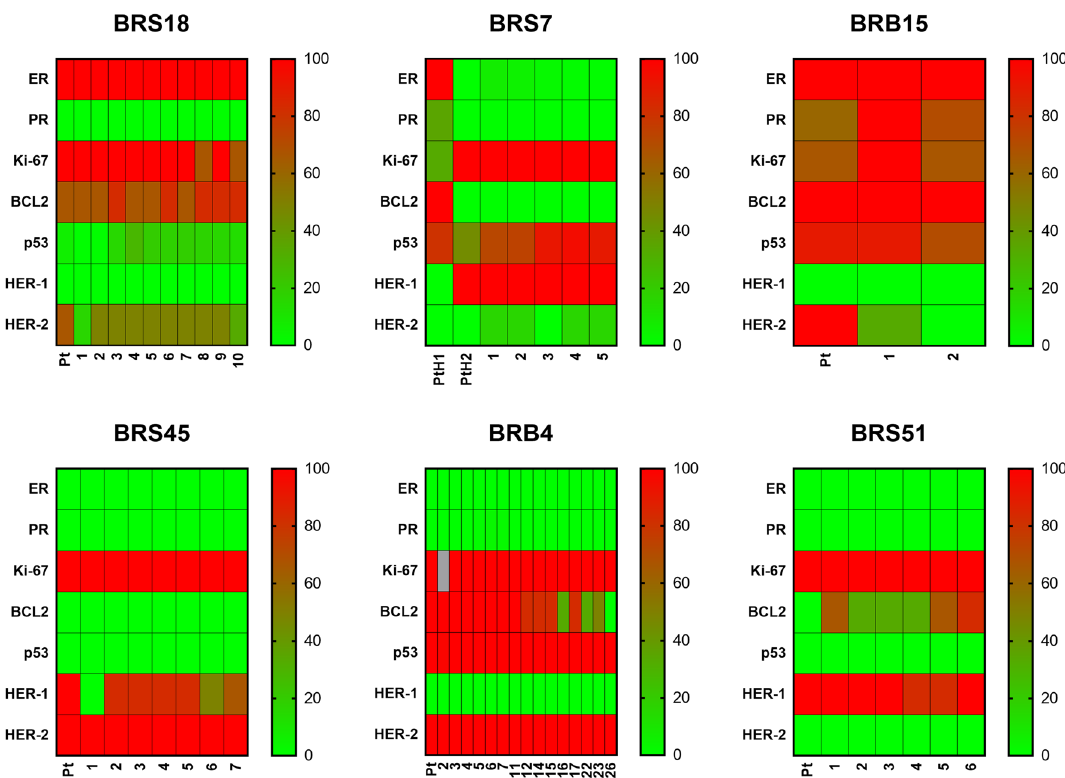
Figure 1. Fidelity and stability of biomarker expression along PDX in vivo passages. Expression data (see Supplementary Table S1 for quantitative data) are represented in a color-code 0–100 scale, arbitrarily attributed to each biomarker (see Supplementary Materials and Methods S1). Pt patient’s tumor sample. Grey not done. Number of in vivo passages is reported below each graph. For PDX-BRS7 two different histological types were observed in patient’s tumor sample (referred to as PtH1 and